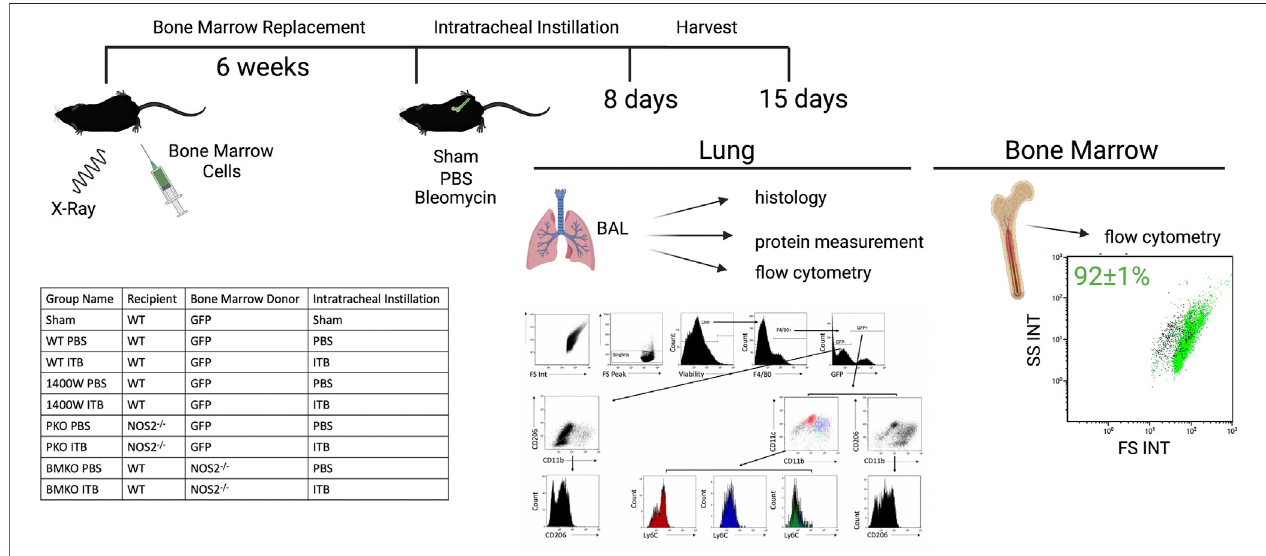
FIGURE 1 | The experimental approach is illustrated to include the method of developing chimeric mice, intratracheal instillation, and endpoints. The table lists the experimentalgroups.The fl owgatingstrategyemployedevaluateslivesinglemacrophage(F4/80+)cellexpressionofGFP,CD11b,CD11c,CD206,andLy6Cinorderto assessorigin,maturity,andactivationcollectedviaBAL.ProteinlevelsweremeasuredinthecellfreeBAL.Lungsweresubsequentlyhistologicallyevaluated.Thepercent of GFP+ cells in the bone marrow was measured by fl ow cytometric detection of GFP expression and reported as mean ± SE. Created with Biorender.com.